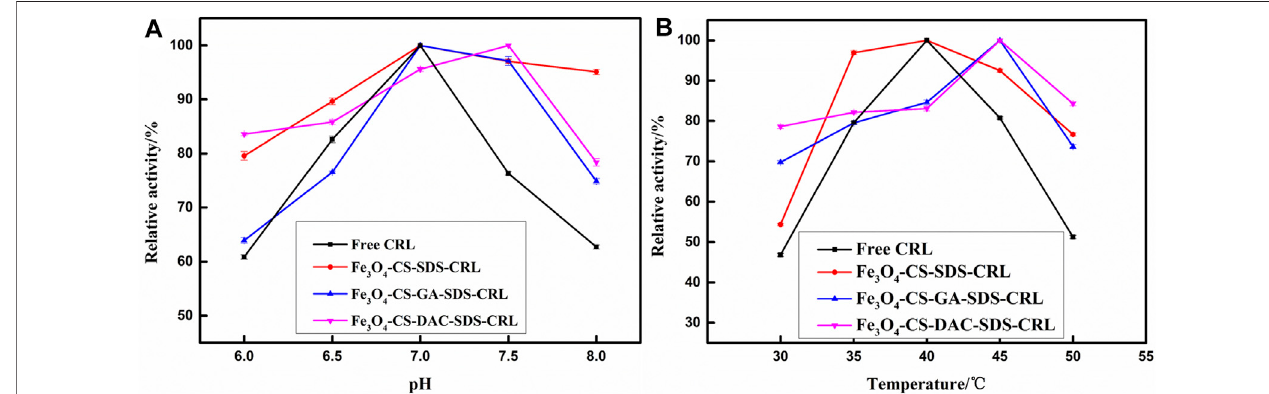
Frontiers in Bioengineering and Biotechnology |